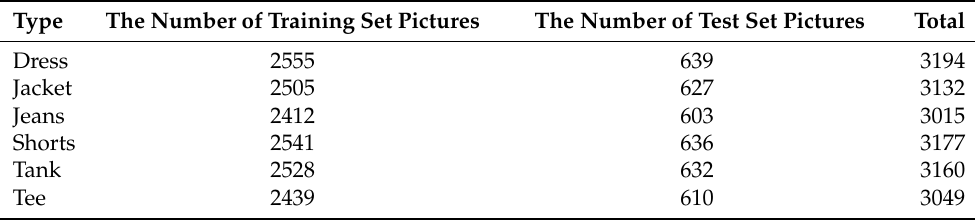
Table 4. Data distribution for the DeepFashion6